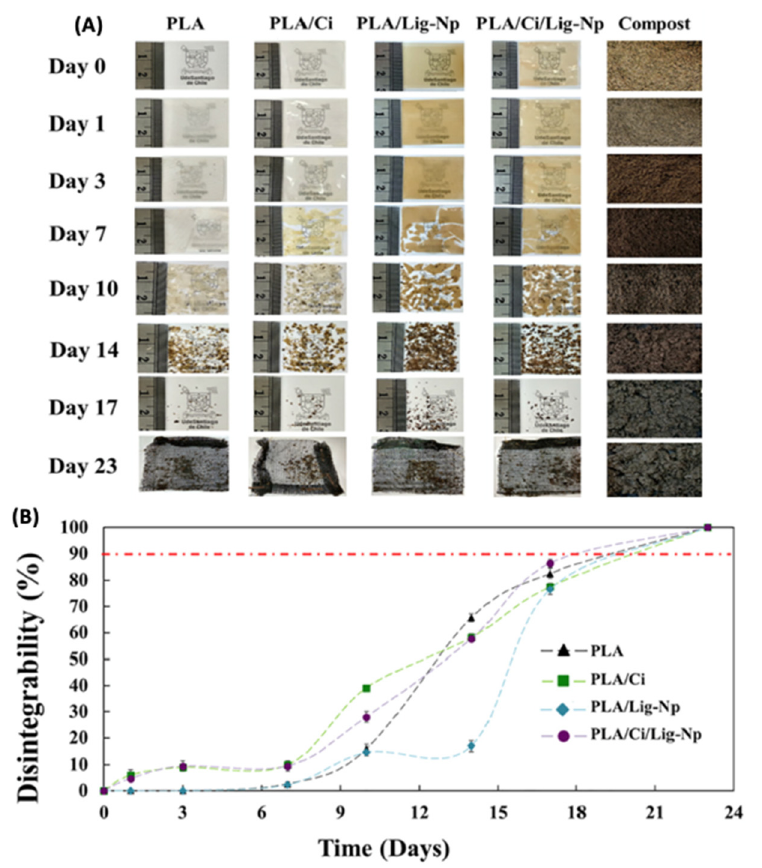
Figure 22. ( a ) Optical observation of prepared films before and after different incubation days under composting conditions and ( B ) % disintegrability degree under composting conditions composting conditions and ( b ) % disintegrability degree under composting conditions [129].